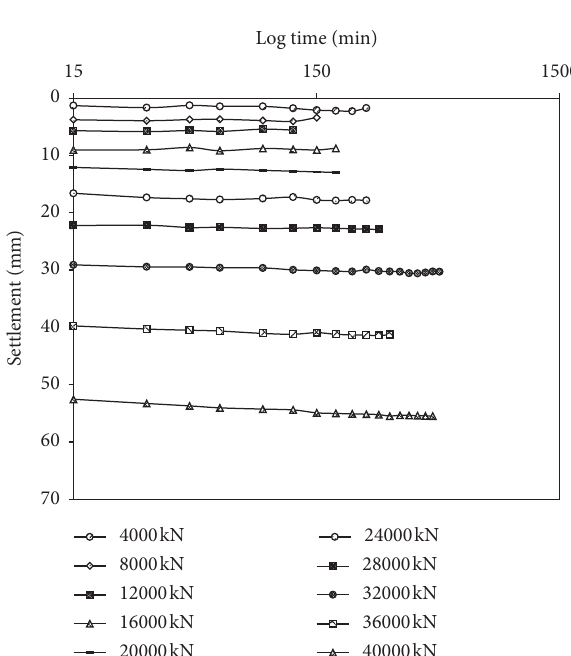
Figure 5: S-lgt results of P12. Figure 6: S-lgt results of